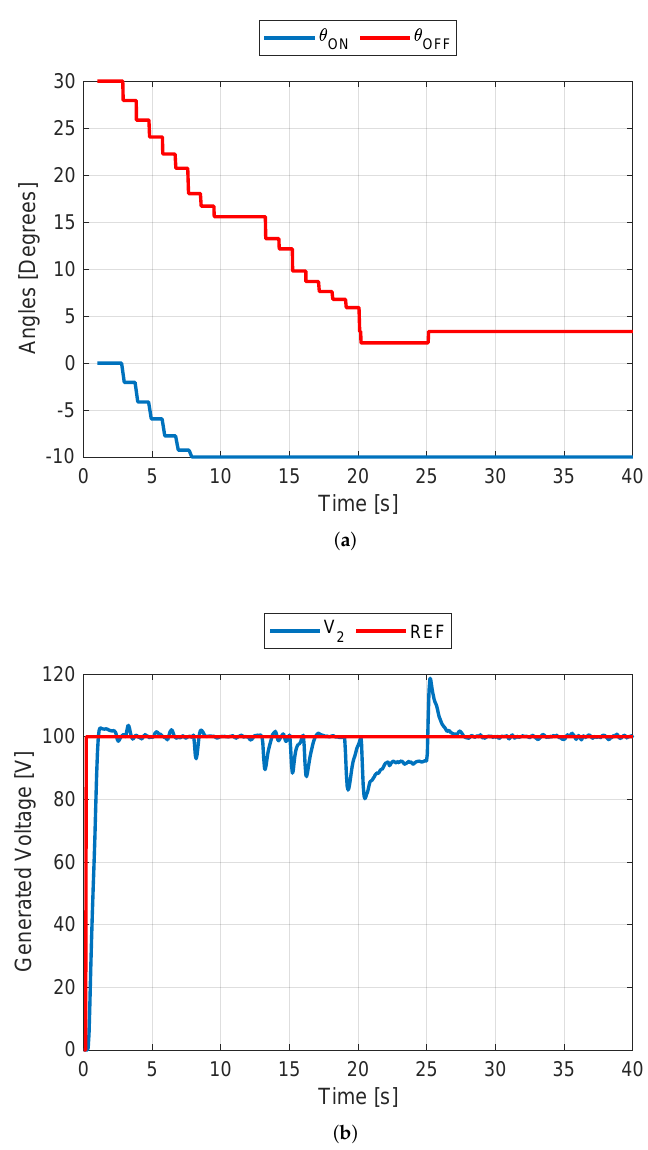
Figure 13. Simulation result for 100 V reference: ( a ) Evolution of angles θ ON and θ OFF with MEPT algorithm; ( b ) Performance of voltage controller inparallel with MEPT